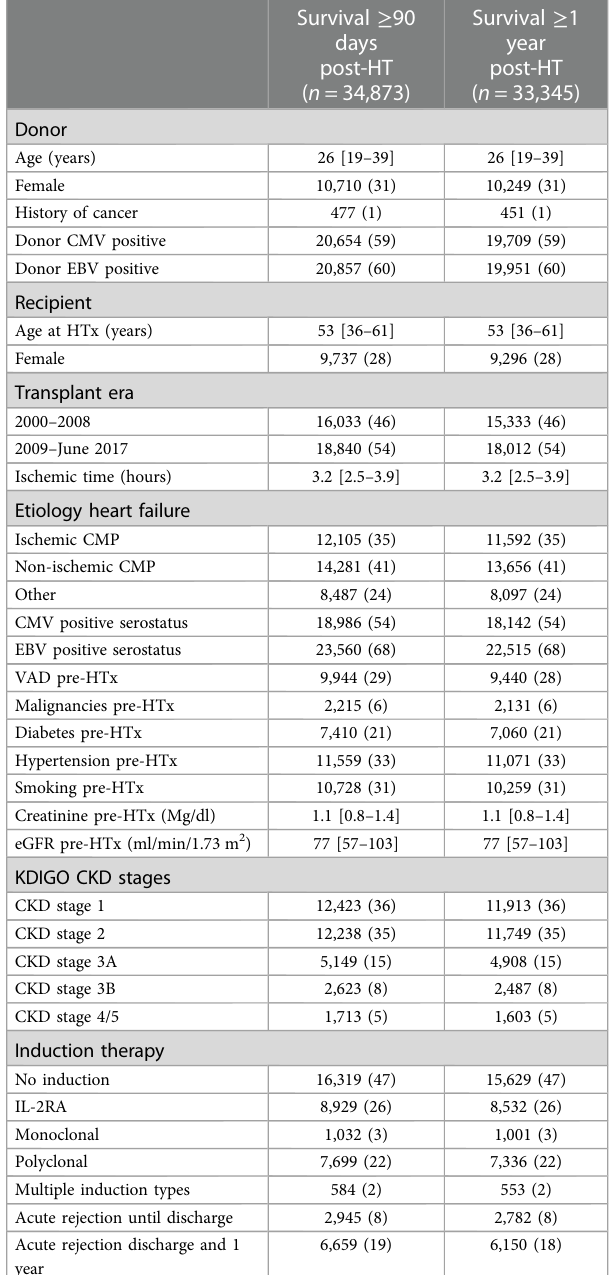
TABLE 1 Baseline characteristics of patients included in the